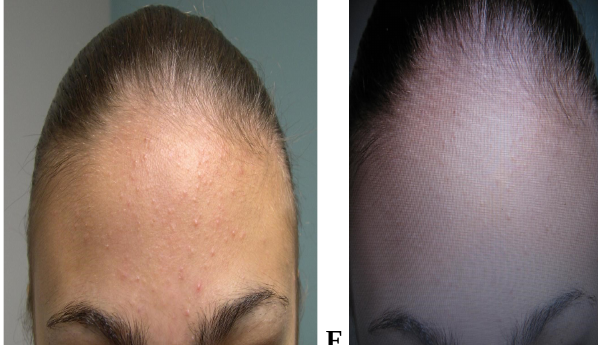
Figure : (13-A) A case of acne GAAS II before Fig (13-B) After 6 weeks of treatment GAAS0 Figure : (14-A) A case of acne GAAS II Fig (14-B) After 6 weeks of treatment GAAS 0